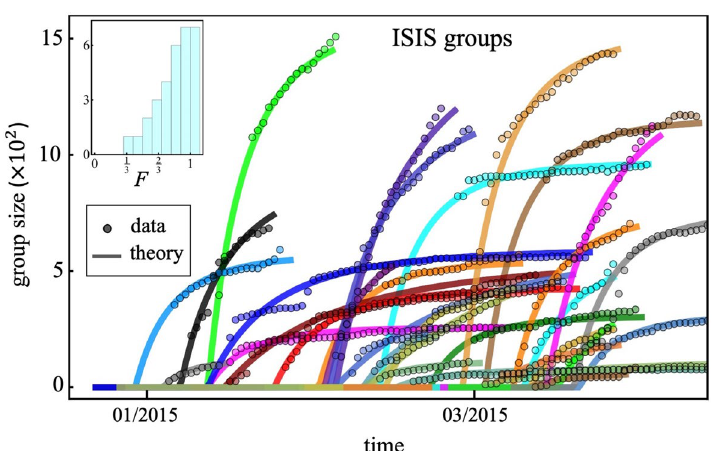
Figure 2. Growth curves of online ISIS groups, analogous to Fig. 1. Each color/curve represents a VKontakte Group that is an ISIS group, the size of which is the number of online members. Their empirical growths (symbols) differ and occur over different timescales. The solid lines show different allowed solutions of the same mathematical equation that incorporates individual user heterogeneity into the online social aggregation process (see Supplementary Information (SI) Eq. (21), with full derivation shown in SI Sect. 2). For visual clarity, only a few of the groups are shown in the main